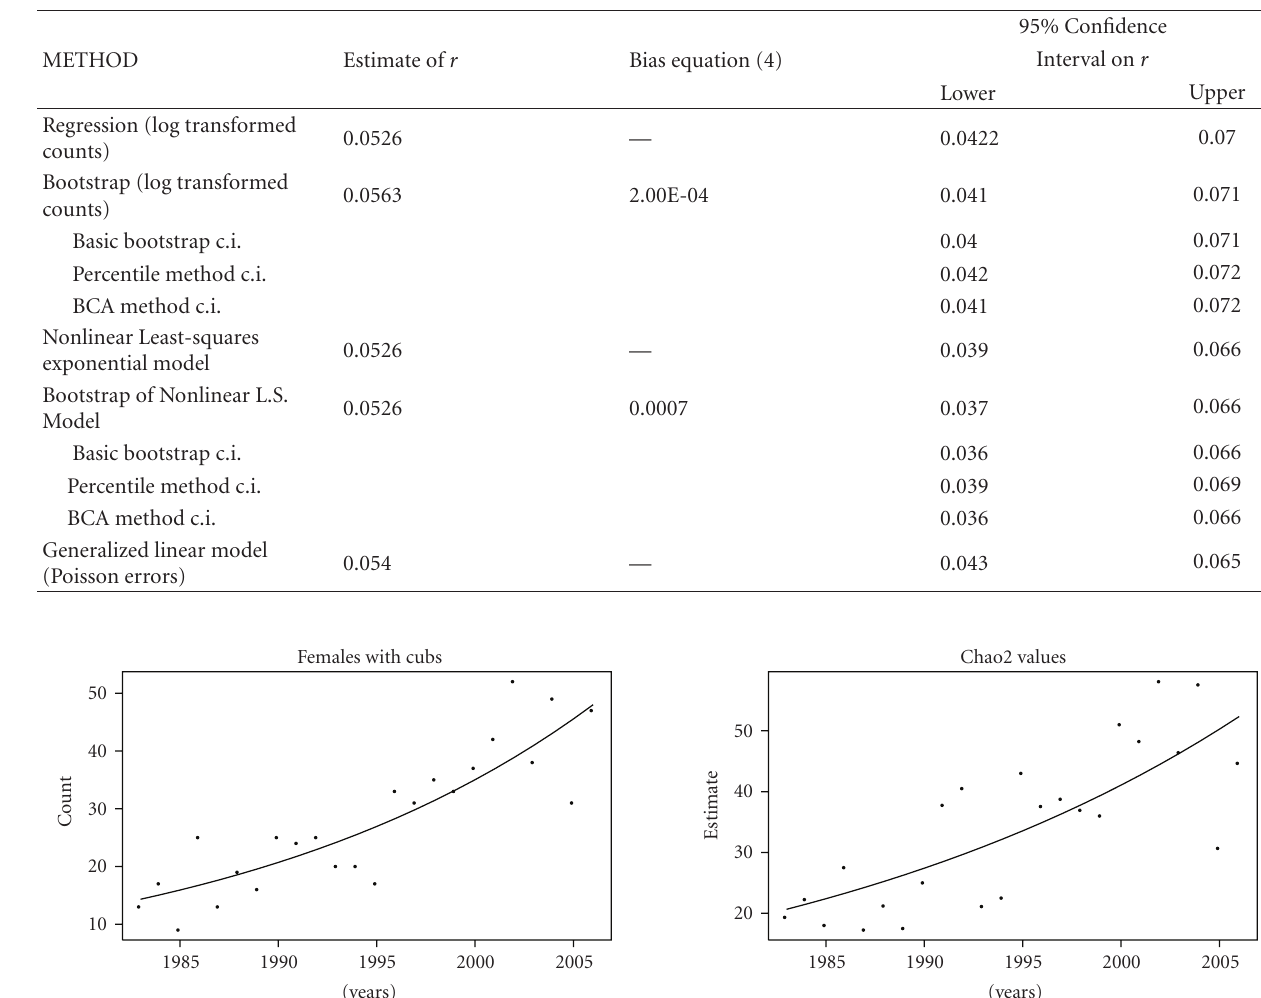
Table 1: Estimates of rate of change ( r ), bias (3), and 95% confidence intervals for various methods of estimation using the exponential model.